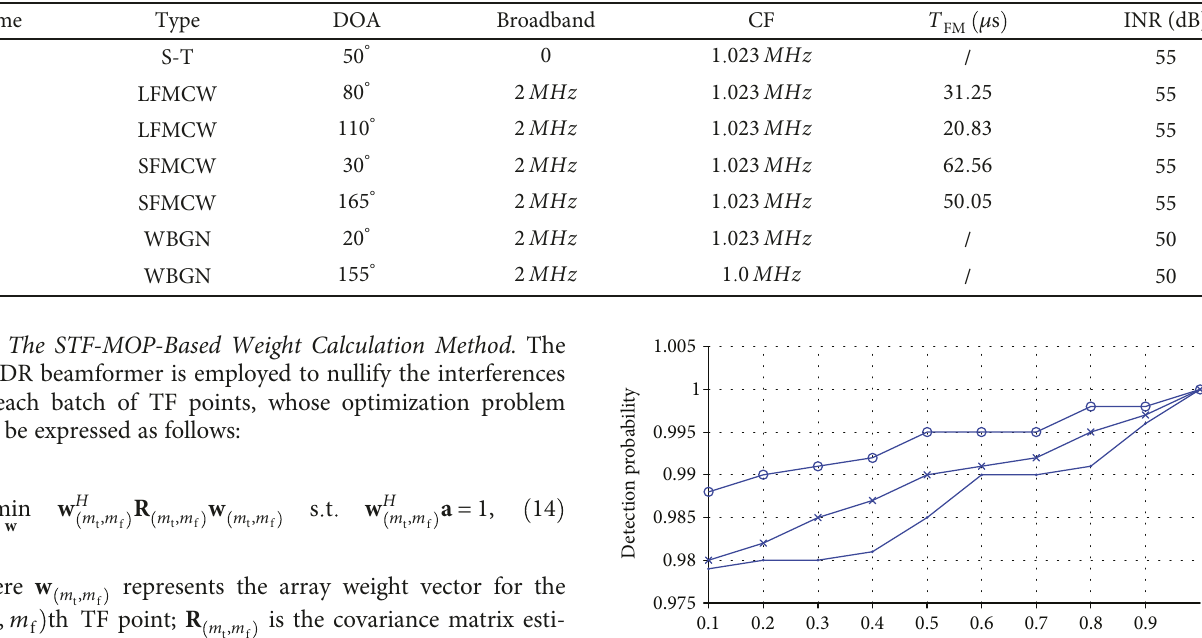
Table 1: Interference signal characteristics.